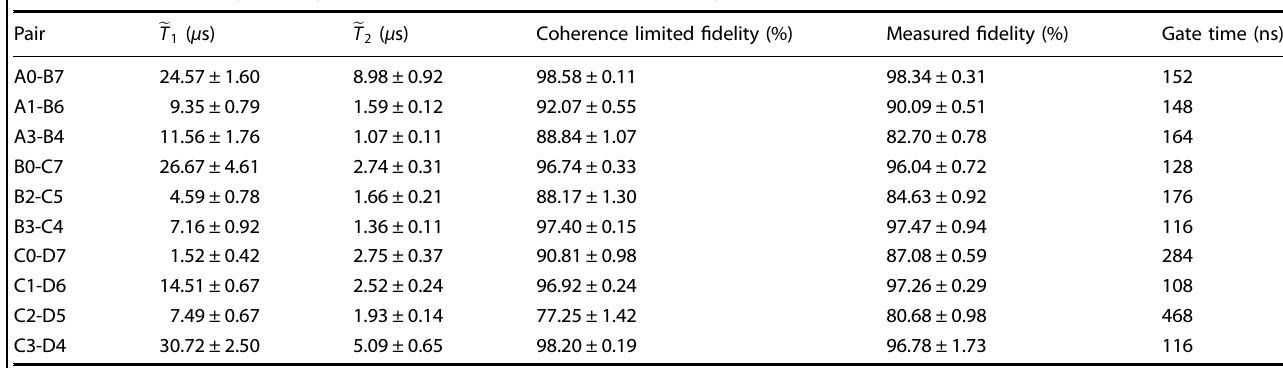
Table 2. Measured fi delity for CZ gates compared with coherence limited fi